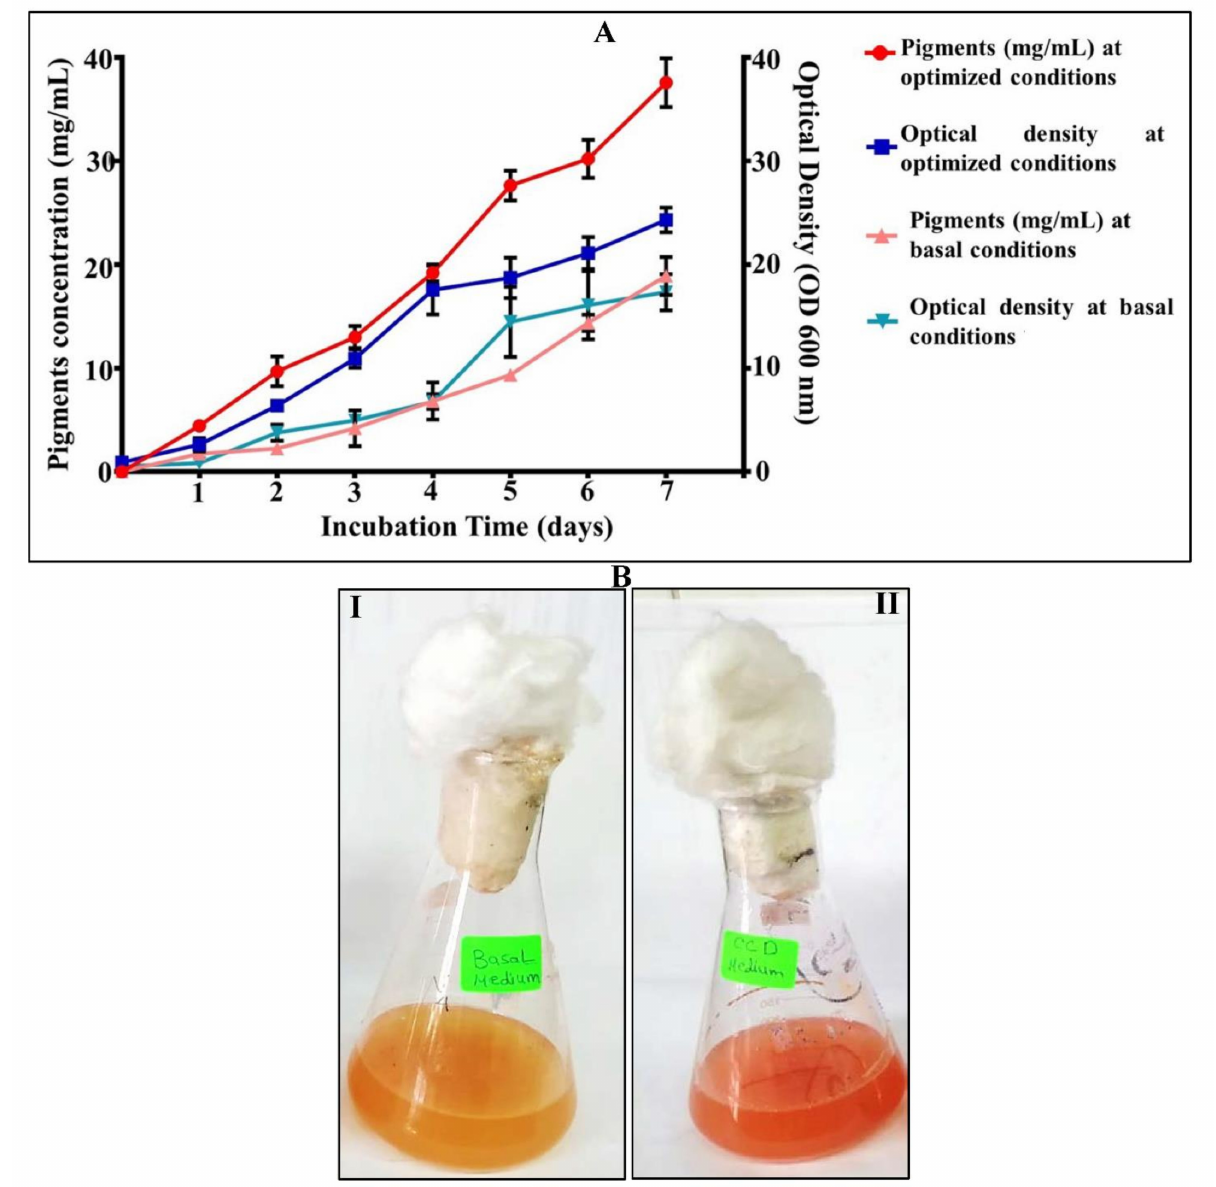
Figure 5. Verification experiment of halophilic carotenoids produced by V. halodenitrificans DASH . ( A ) Comparative analysis of carotenoids’ productivity and optical density under optimized and basal medium as a function of incubation time (7 days) with time interval (24 h). The average of three replica were carried out for each one. ( B ) Photographic image representing verification step. I-under basal unoptimized conditions, II-under predicted optimum